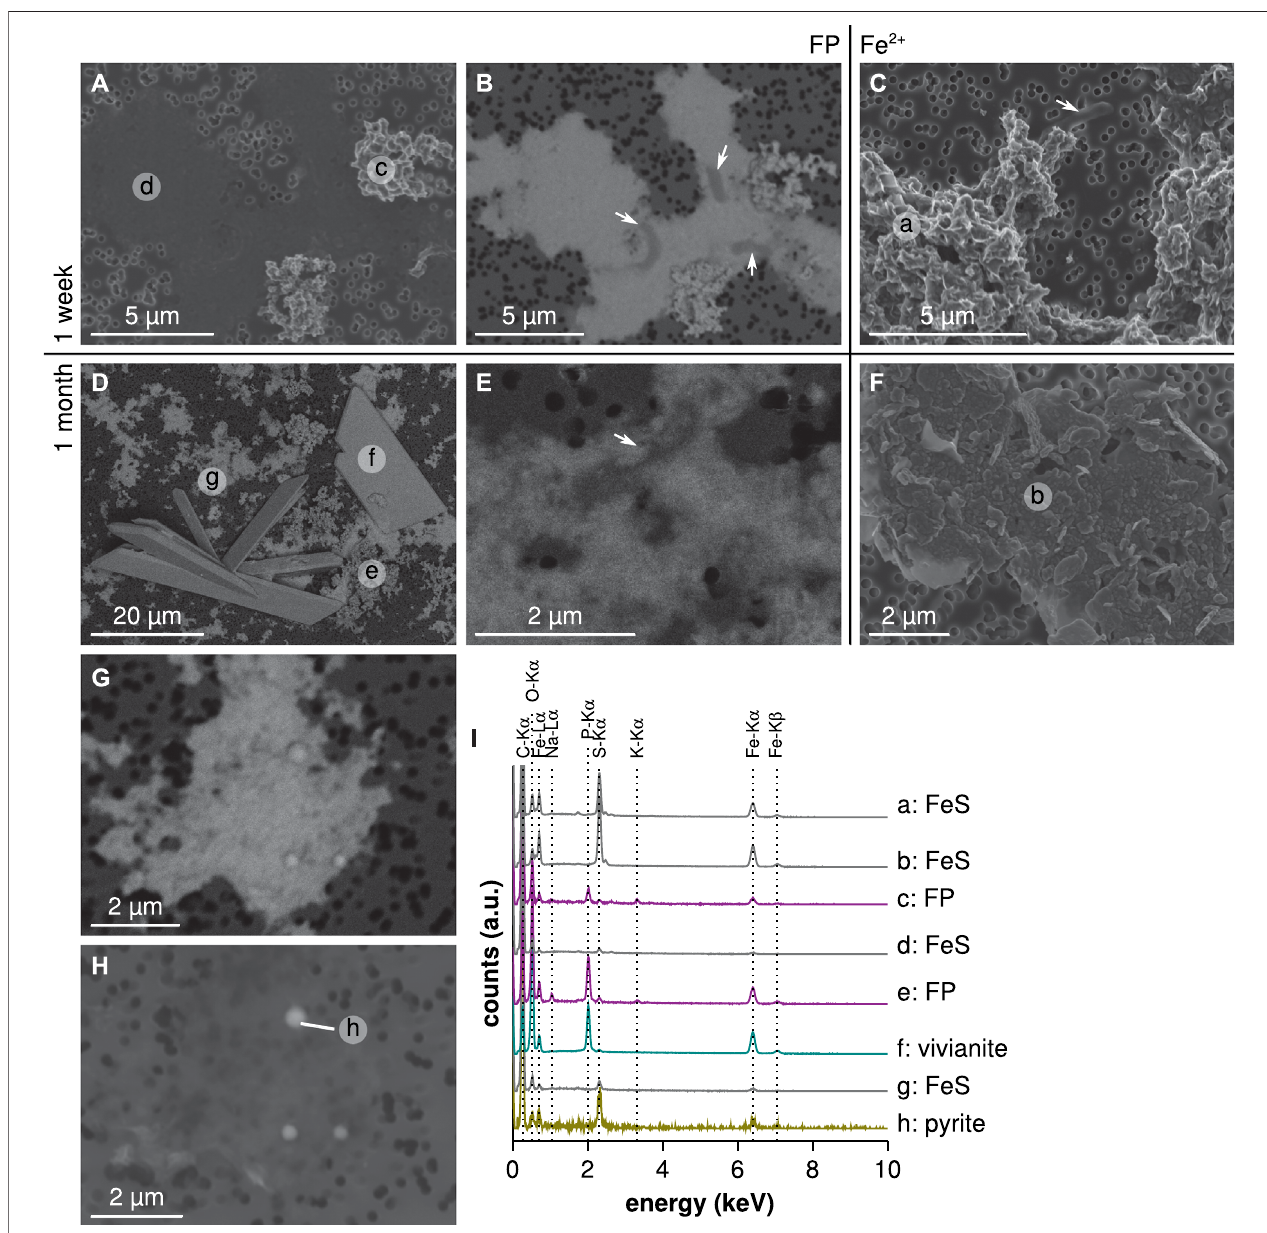
FIGURE3 | SEM observations ofprecipitatesobtained inboth conditions, after 1 week and 1 month. (A , B) Comparison ofsecondary and backscattered electron images showing amorphous iron sul fi de association with bacteria for FP-nano condition at 1 week. (C) Secondary electron images of Fe-diss condition at 1 week. (D) Large backscattered electron image at 1 month in FP-nano condition. (E) Backscattered electron image showing a bacterium within iron sul fi de fi lm at 1 month in FP- nano condition. (F) Secondary electron images of Fe-diss condition at 1 month. (G , H) Comparison of backscattered and secondary electron images showing pyrite spherules nucleating within the iron sul fi de fi lm at 1 month in FP-nano condition. (I) Energy dispersive X-ray spectrometry spectra pinned from previous SEM images.LettersinenergydispersiveX-rayspectrometrymapscorrespondtoenergydispersiveX-rayspectrometryspectraprovidedin (I) .Exceptfor (H) ,allimageswere acquired in low-voltage